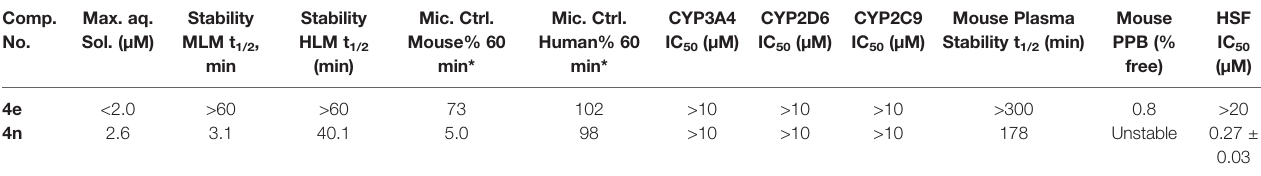
TABLE 4 | In Vitro Physicochemical/ADME Data and human skin fi broblasts (normal cell line) cytotoxicity for 4e and 4n . Comp.